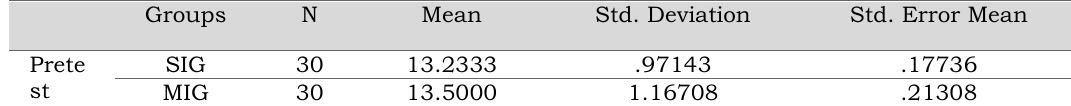
Table 1. Descriptive statistics for the pretest